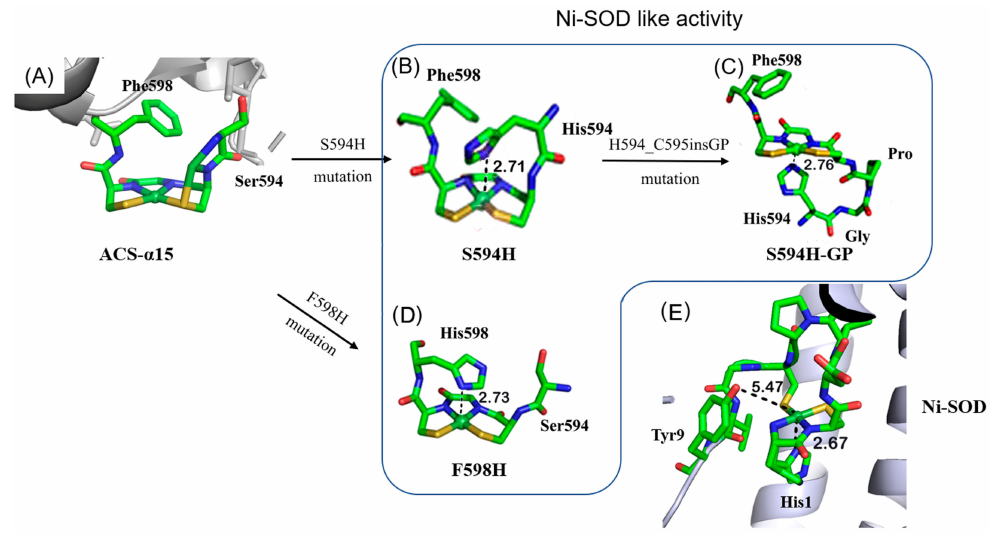
Figure 1. X-ray crystal structure of the truncated ACS protein ACS- α 15 (PDB: 3S2X, from Moorella thermoacetica .) ( A ); modeling structure of the designed Ni-SOD-like metalloprotein S594H ( B ); S594H- GP ( C ); F598H ( D ); and X-ray crystal structure of Ni-SOD (PDB: 1T6U, from Streptomyces coelicolor .) ( E ).